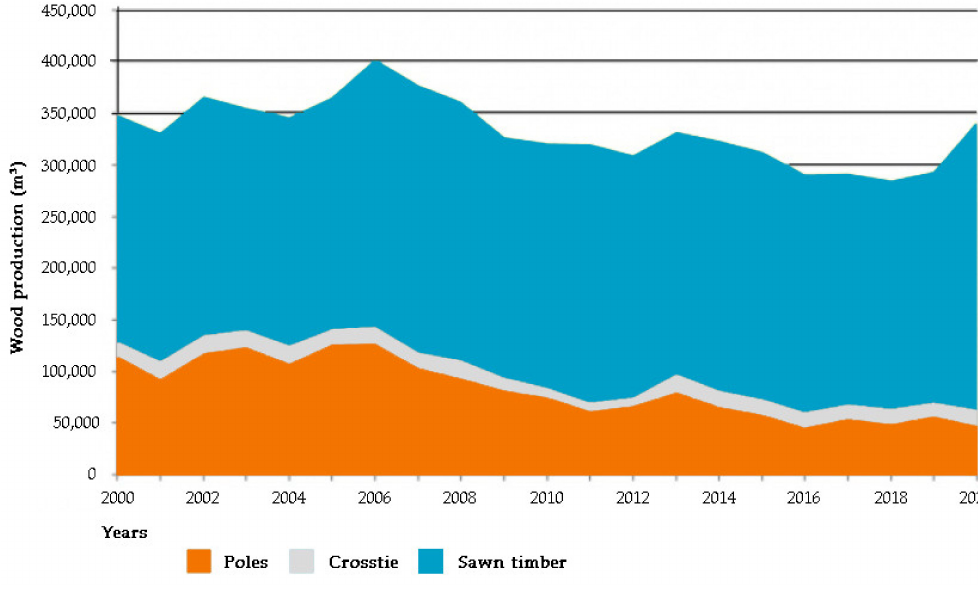
Figure 8. Industrially impregnated wood in Finland